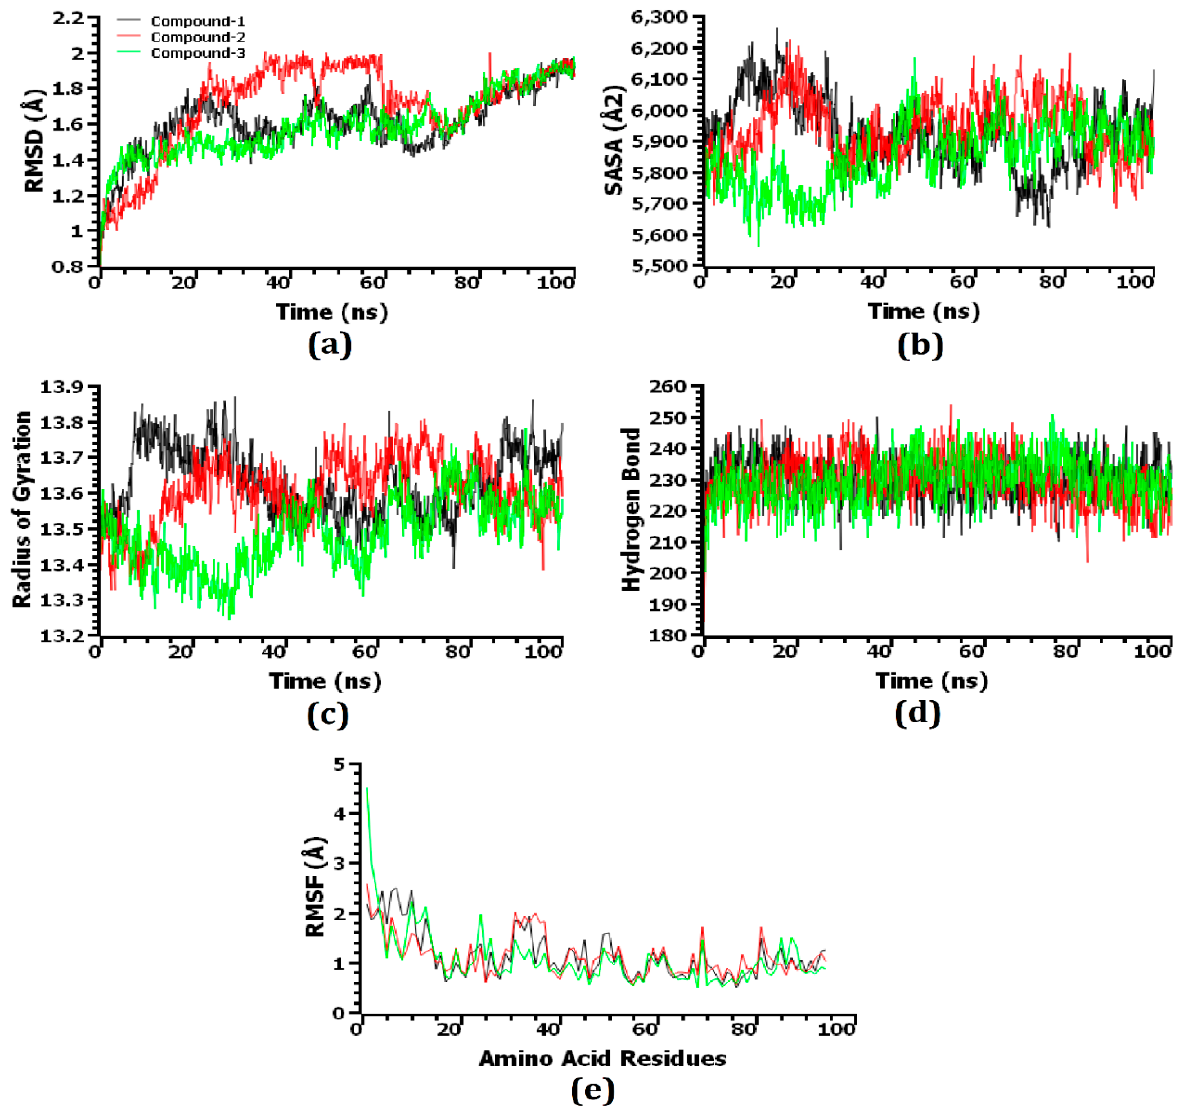
Figure 7. The simulated systems were analyzed on a time series basis. From ( a ) to ( e ), the RMSD of alpha carbon atoms is denoted by ( a ), protein volume with the expansion is denoted by ( b ), rigidity and compactness of the complexes are represented by ( c ), hydrogen bonding is represented by ( d ), and the flexibility of amino acid residues is denoted by ( e ).